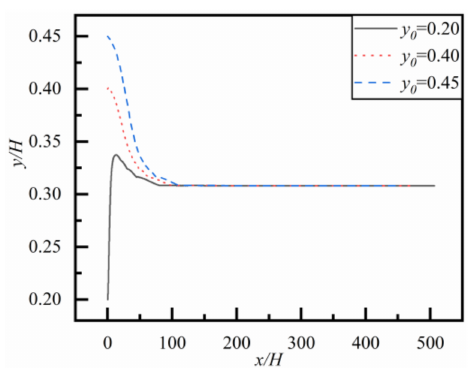
Figure 4. Particle trajectories in Poiseuille flow.